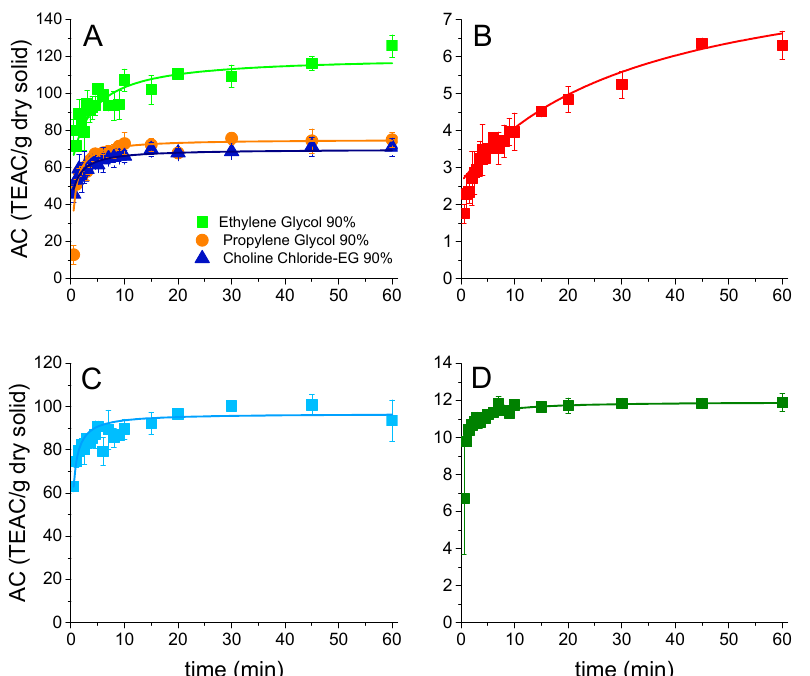
Figure 10. Antioxidant activity (DPPH) results, and their kinetic analysis, obtained during the extraction processes applied to GP using several solvents: ( A ) glycols at 70 ◦ C; ( B ) acetone at 25 ◦ C, ( C ) acetone 80%: water 20% at 25 ◦ C, and ( D ) water at 25 ◦ C. The lines show the second-order kinetic model (Equation (1)) fitting to data.